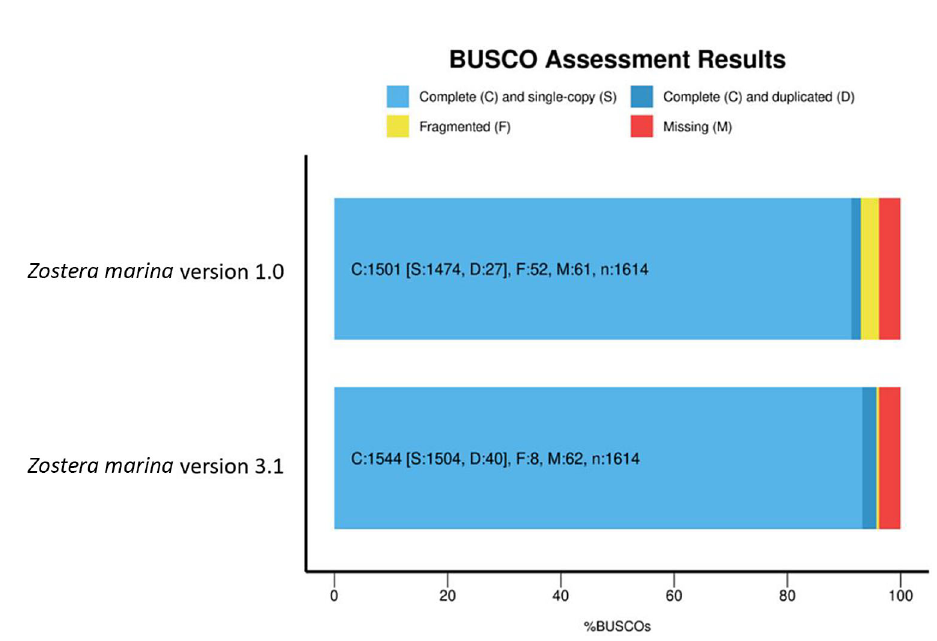
Figure 1. Busco assessment results for Z. marina genomes v1.0 and